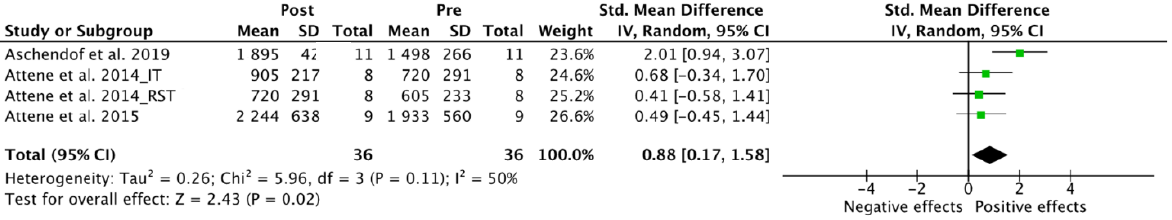
Figure 7. Forest Plot comparing the effect of multidisciplinary interventions on endurance [63,65,79].